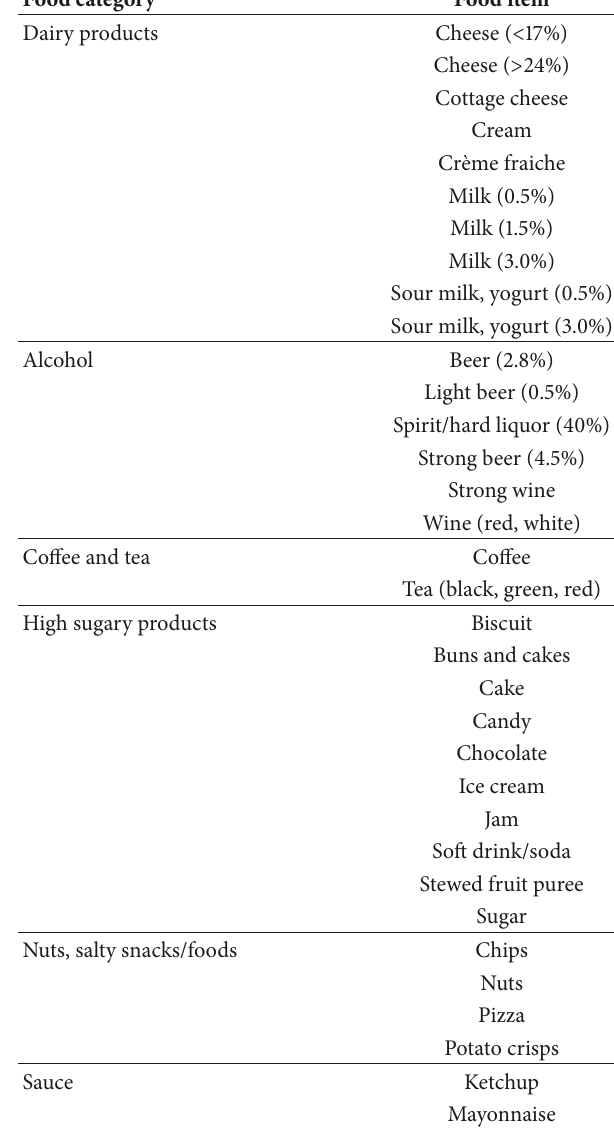
Table 4: Food categorization. Food